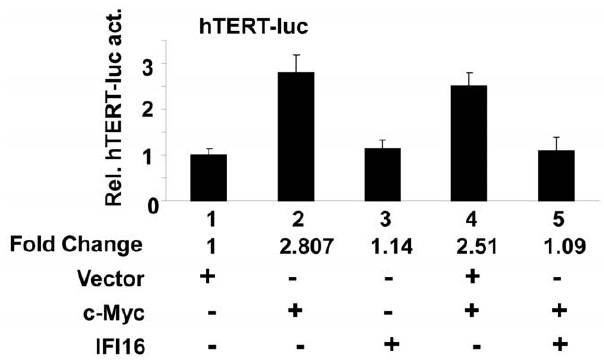
Figure 5. The IFI16 protein inhibits c-Myc-induced transcription of the hTERT gene. Sub-confluent cultures of young WI-38 cells were transfected with hTERT-luc reporter plasmid (1.8 m g) along with a second reporter pRL-TK (0.2 m g) plasmid and an empty vector (pCMV), c-Myc encoding plasmid, or IFI16 encoding plasmid as described in methods. 40–44 h after transfections,firefly luciferase and Renilla luciferaseactivities were assayed using dual-luciferase reporter assay kit. Relative luciferase activity was expressed as the ratio of the firefly luciferase and Renilla luciferase activity. The numbers indicate fold change in the activity of the firefly